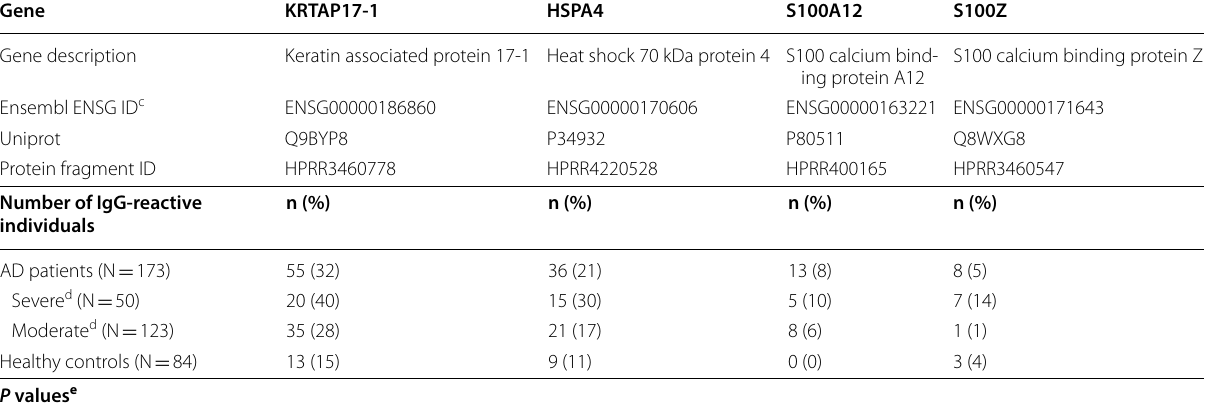
Table 2 IgG-reactivity a and adjusted MFI b to four antigens detected in the targeted screening of the complete cohort using antigen bead